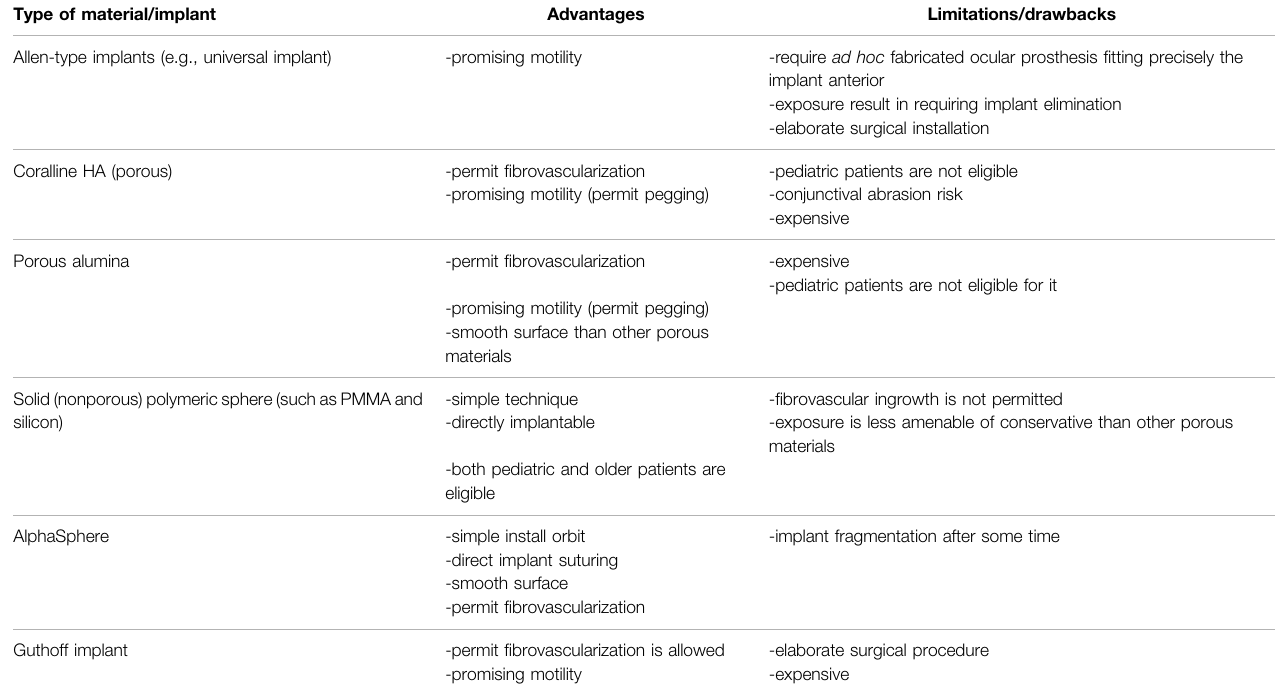
TABLE 1 | Various implants and materials with their advantages and